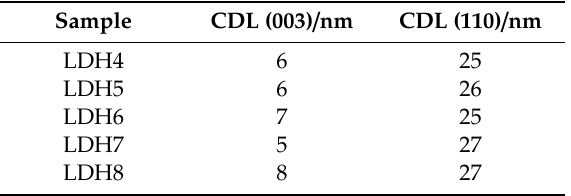
Table 8. Scherrer approximation of crystal domain length (CDL).